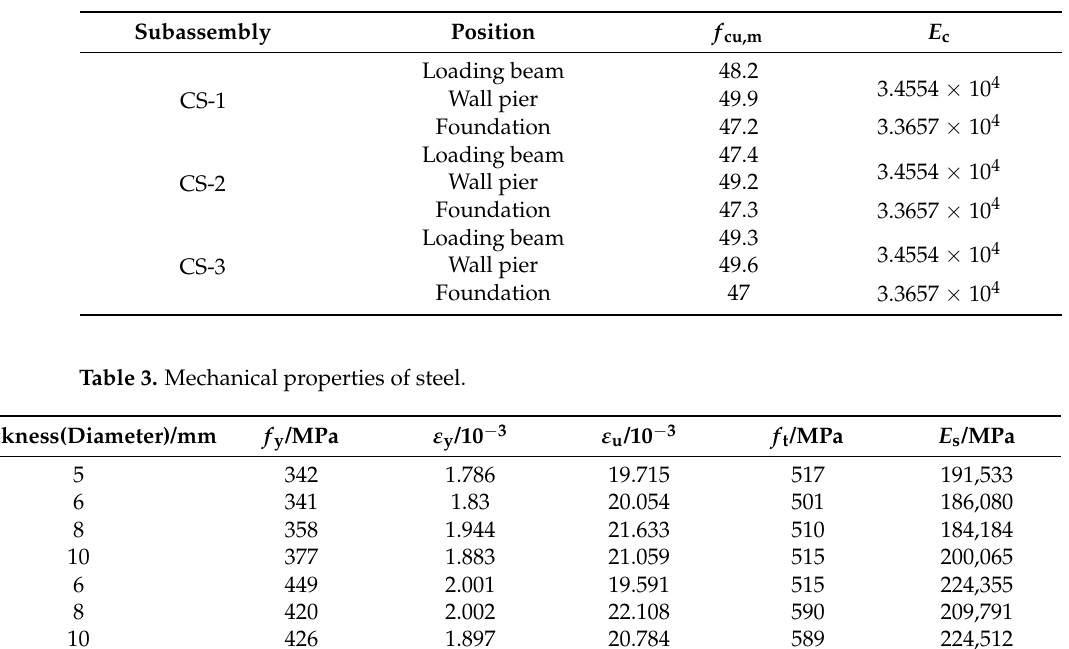
Figure 11. Layout of strain gauges in different components. ( a ) Strain gauges in steel bars; ( b ) Strain gauges in SCBs, steel plates and VBEs.